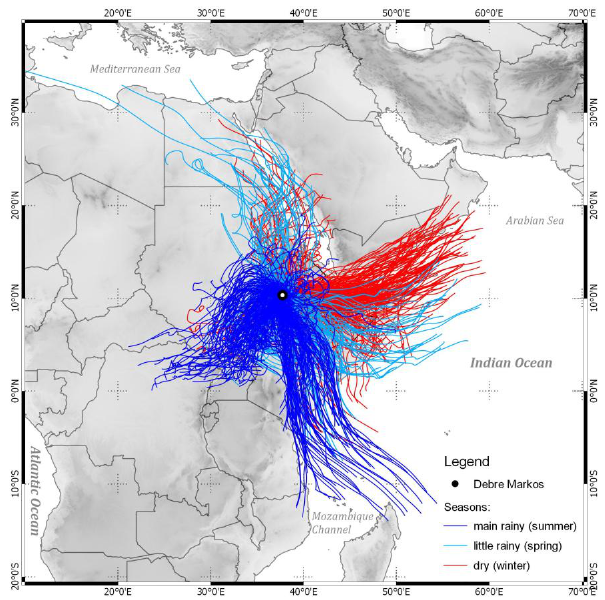
Figure 11. Potential source areas of precipitation to the study area in different seasons. Lines indicate the starting points of 14-day backward calculated trajectories. The black dot indicates the location of the study area.